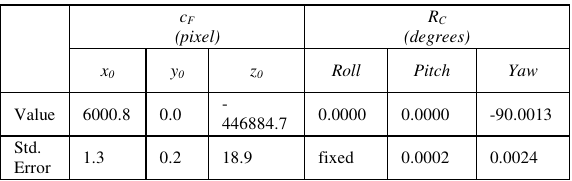
Table 1. Computed IO parameters and detector mounting